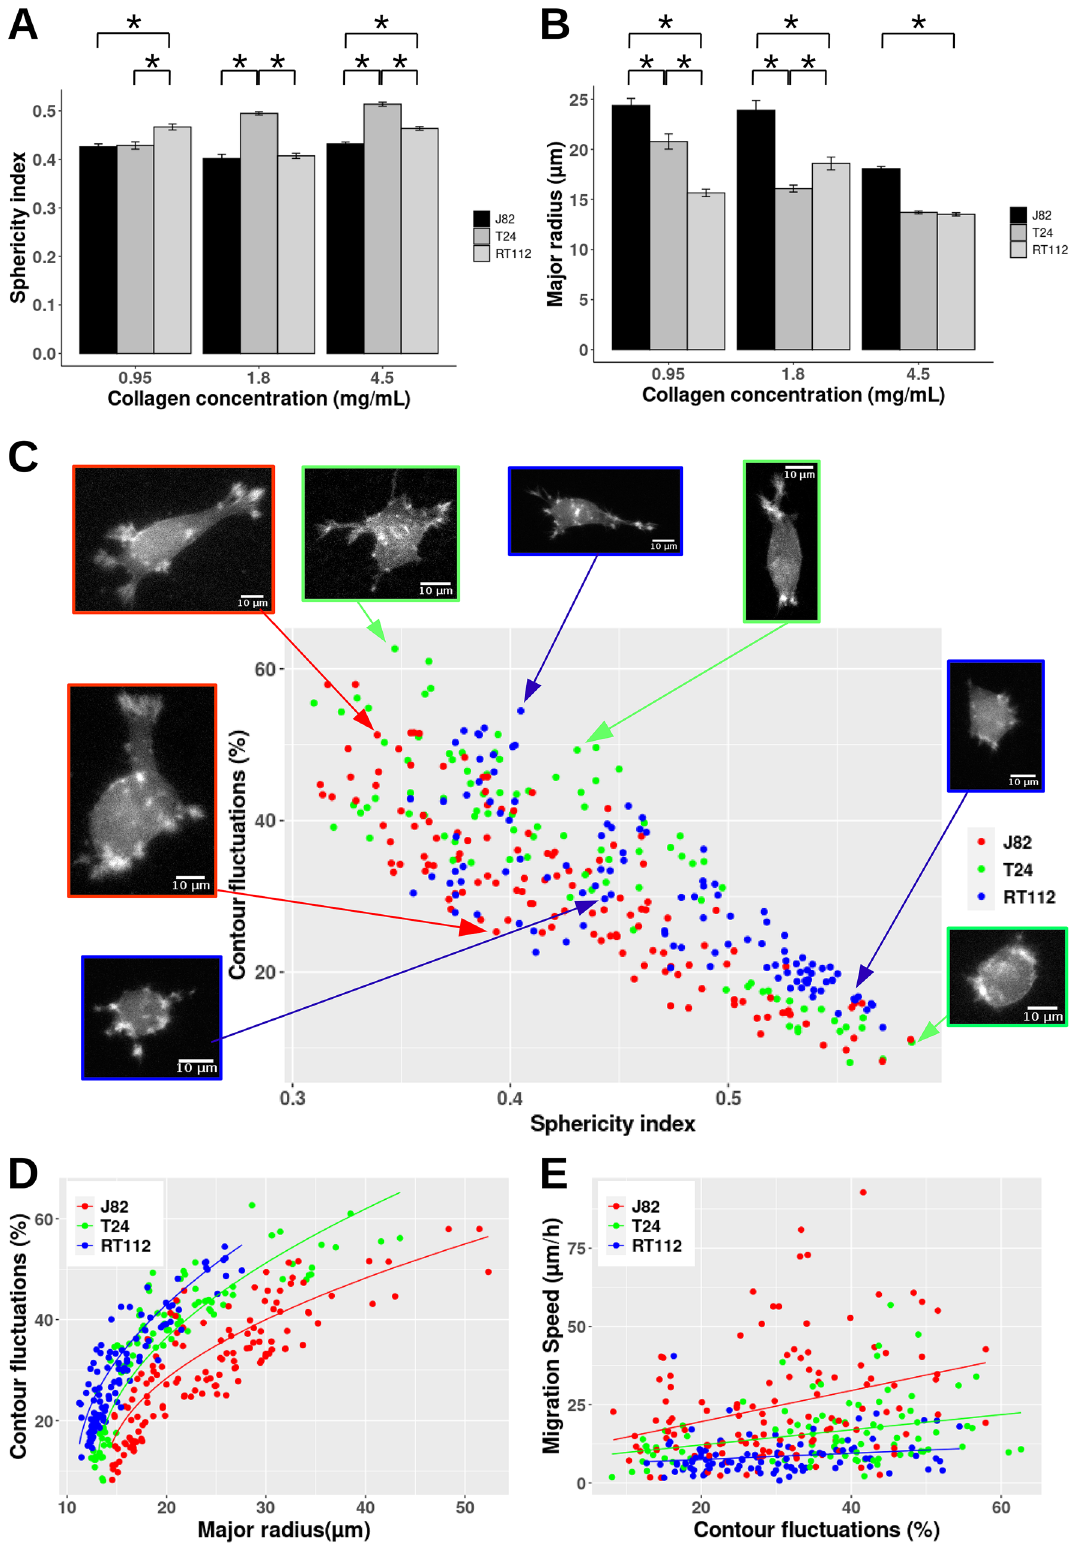
Figure 2. ( A ) Mean sphericity index ( ψ ) for different cancer cells (RT112, T24 and J82) in various collagen gels (0.95 mg/mL to 1.8–4.5 mg/mL). *p < 0.05 (Kruskal Wallis test). Error bars represent mean ± SEM. ( B ) Mean major radius ( R ) of different cancer cells at low, intermediate and high collagen concentrations. ( C ) Graph representing contour fluctuations ( ν ) vs. sphericity index ψ . Insets show various shapes used by cancer cells of various invasiveness (blue for RT112 cells, green for T24 cells, red for J82 cells). ( D ) graph 1 / 2 of contour fluctuations ( ν ) vs. major radius ( R ) in μm. Solid line: power fit of ν = A + B * (R − C) with A = 10, 10, 10; B = 7.5, 10, 11; C = 14, 13, 11 respectively for J82, T24 and RT112 cells. ( E ) Migration speed (V) vs. contour fluctuations ( ν ). Fits V = a* ν + b with a = 0.5, 0.25, 0.1 μm/h; b = 9.6, 7.3, 5.5 μm/h, for J82, T24 and RT112